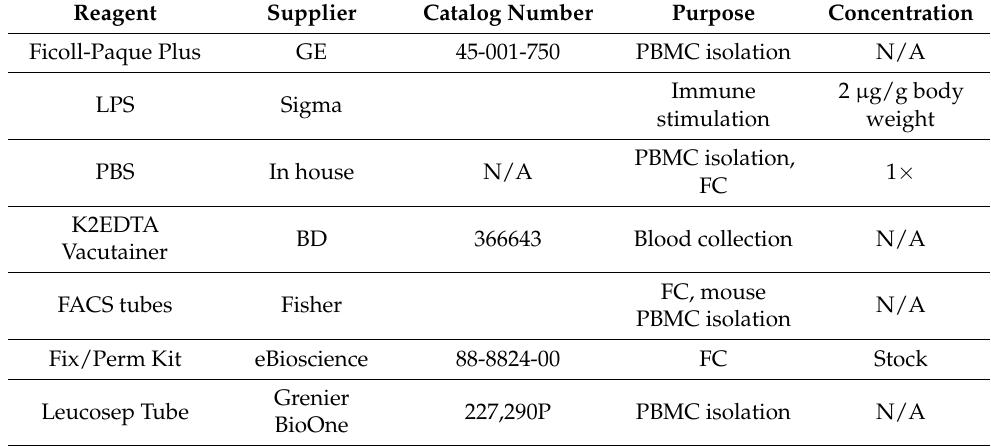
Table 1. Reagents and